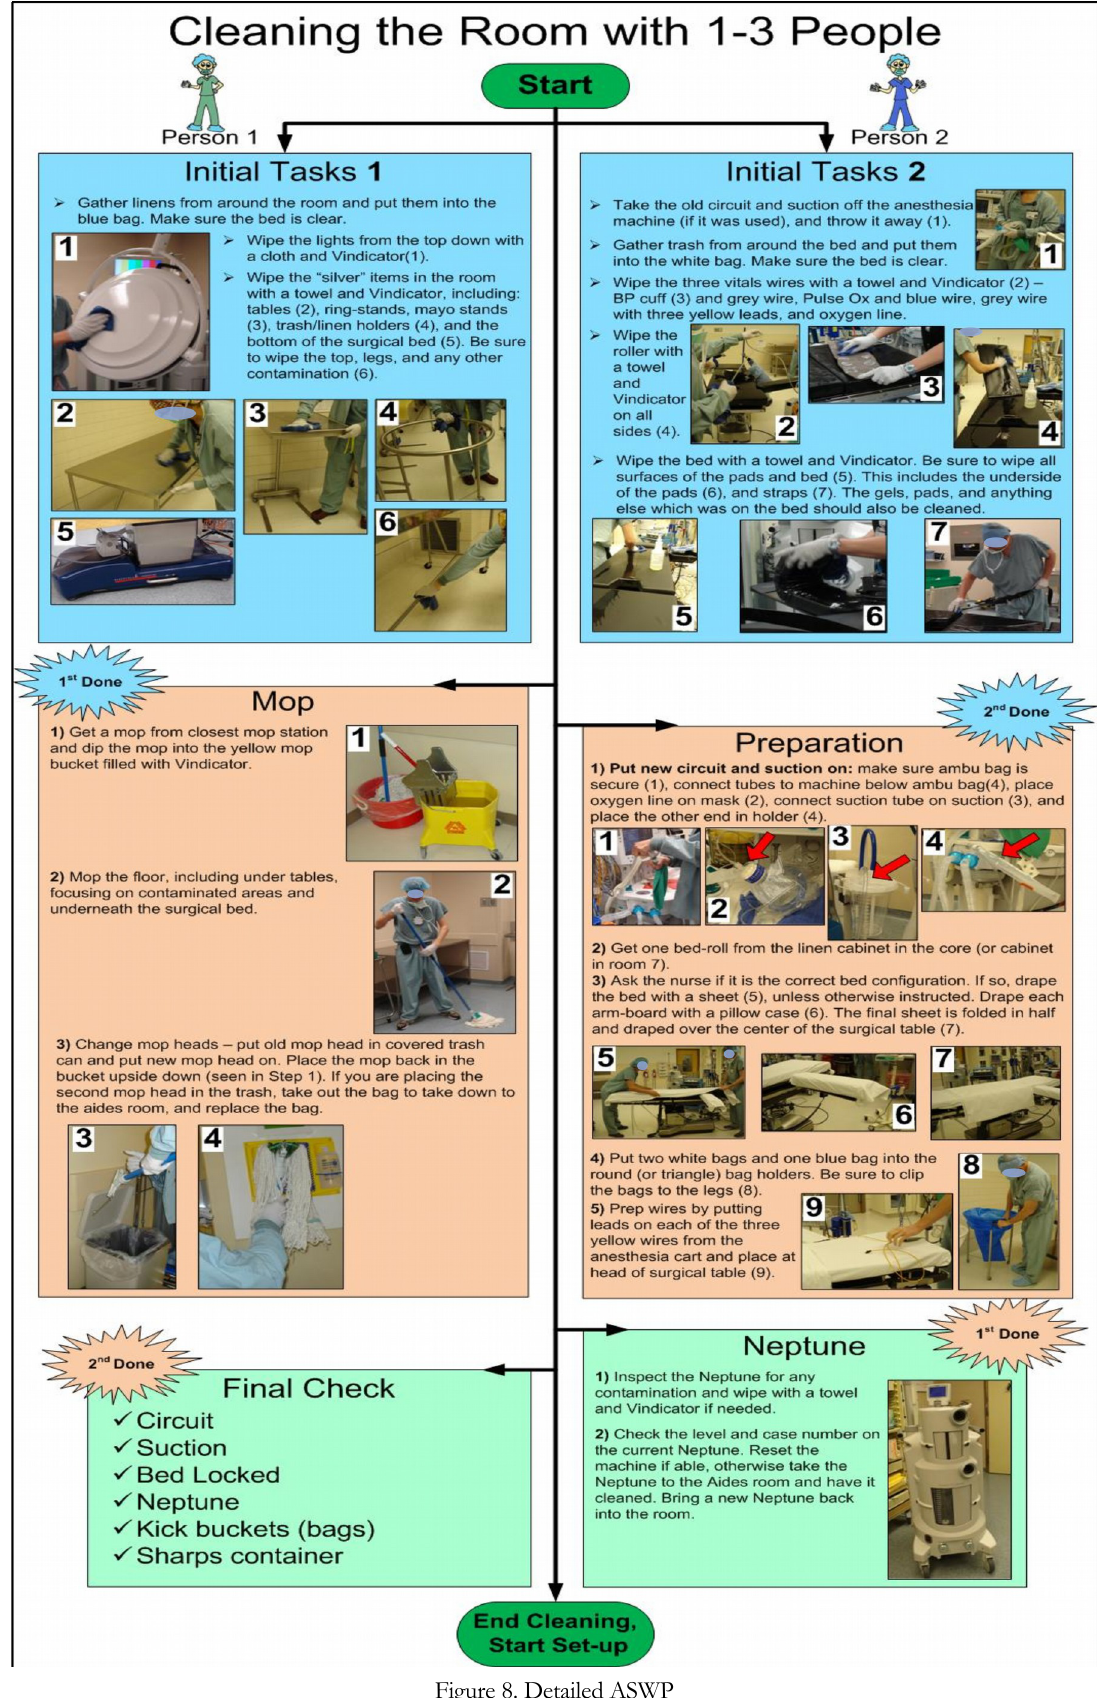
Figure 8. Detailed